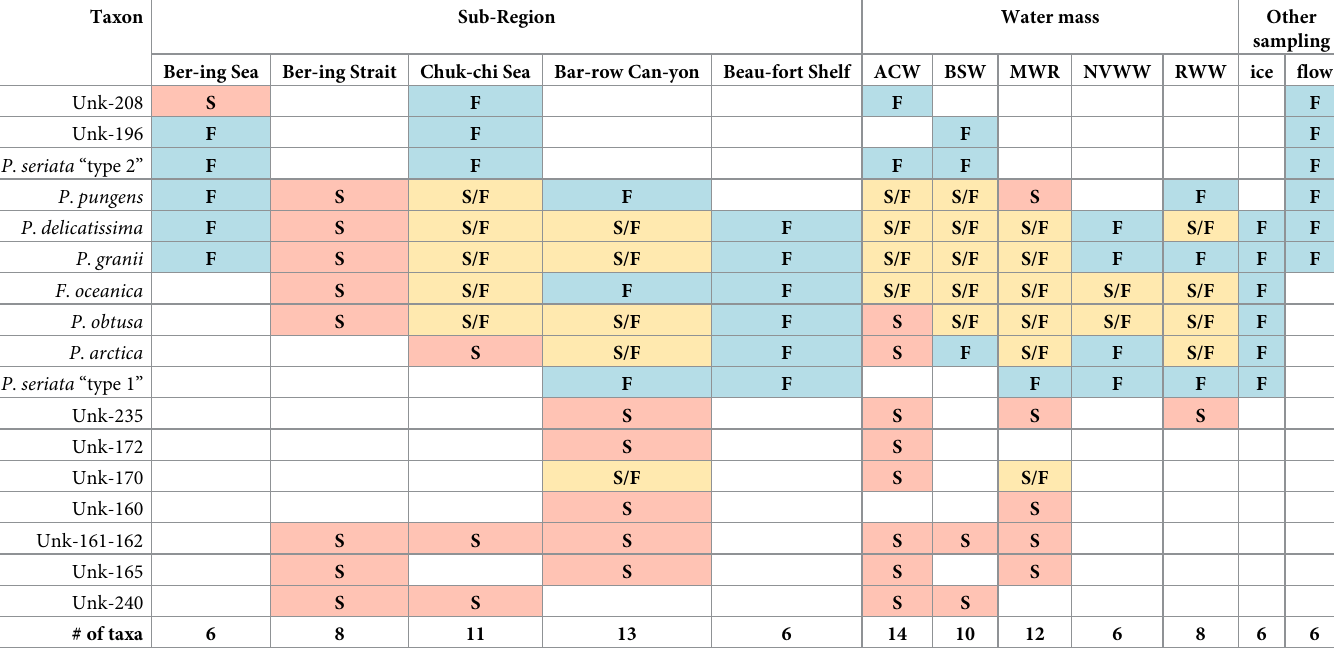
Table 5. Species detected with ARISA in sampled sub-regions and water masses.